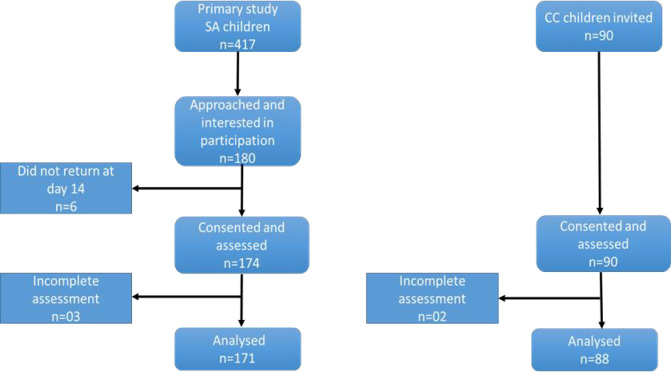
Study profile and assessment for the Bayley III.